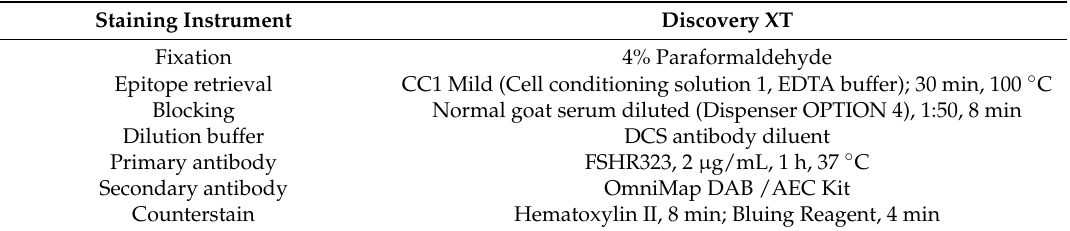
Table 2. Anti-FSHR staining conditions by using automated IHC research slide staining